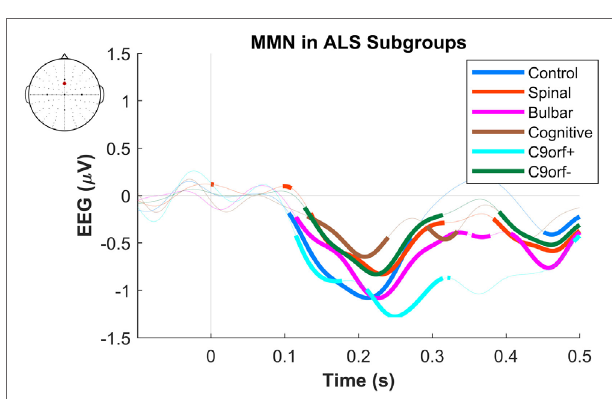
FigUre 1 | Presence of robust mismatch negativity responses in both patient and control groups. The auditory event-related potentials (ERPs), as well as their difference are shown. The shades indicate the SEM. See text for statistics and significance ( p < 0.05).